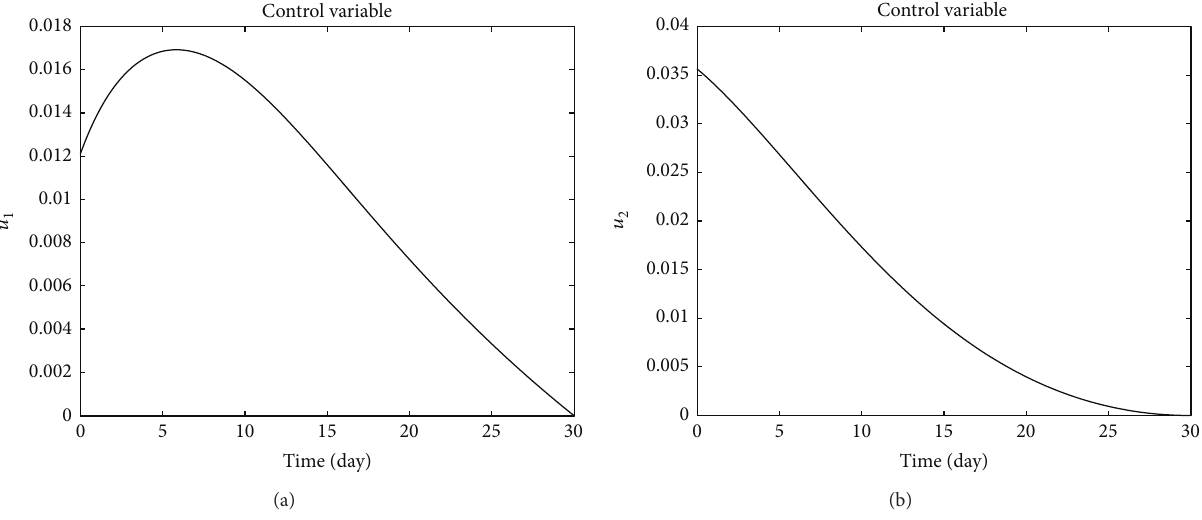
Figure 13: Plot of the optimal controls, 𝑢 1 ̸= 0 , 𝑢 2 ̸=0 .